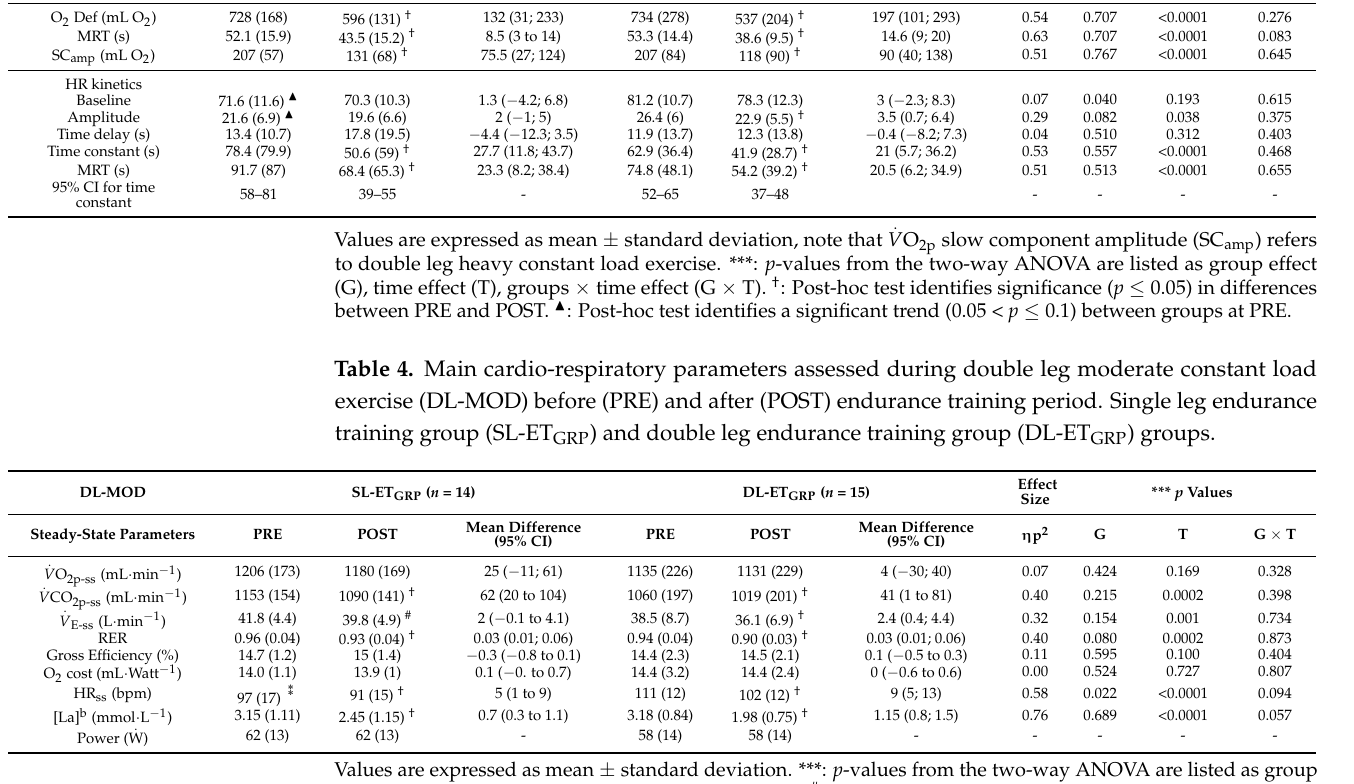
. V O 2p ) and heart rate (HR) kinetics parameters assessed during Table 3. Pulmonary O 2 uptake ( double leg moderate constant load exercise (DL-MOD) before (PRE) and after (POST) endurance training period. Single leg endurance training group (SL-ET GRP ) and double leg endurance training group (DL-ET GRP ) groups. SL-ET GRP ( n =14) DL-ET GRP ( n =13) Effect Size *** p Values PRE POST MeanDifference (95%CI) η p 2 G G × T